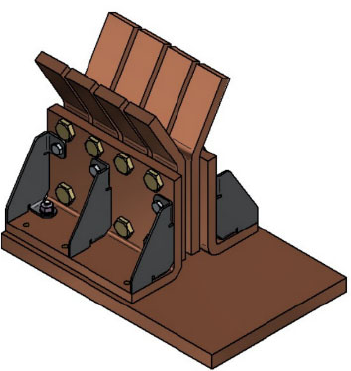
Figure 1. High current direct contact from Ampac [29].